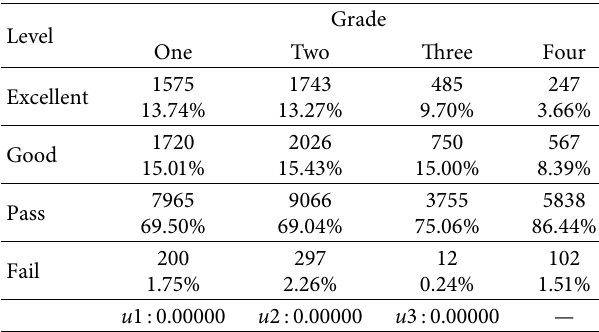
Table 3: Performance and grade ratio of boys’